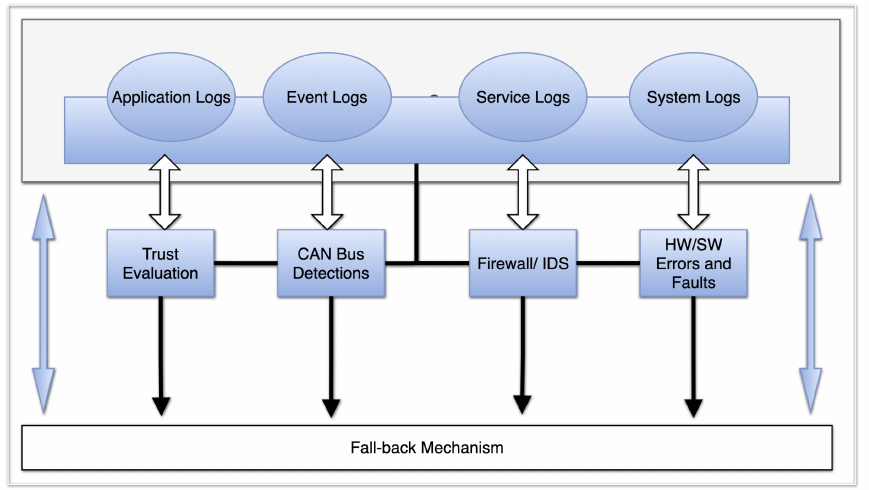
Figure 21. Overview of middleware